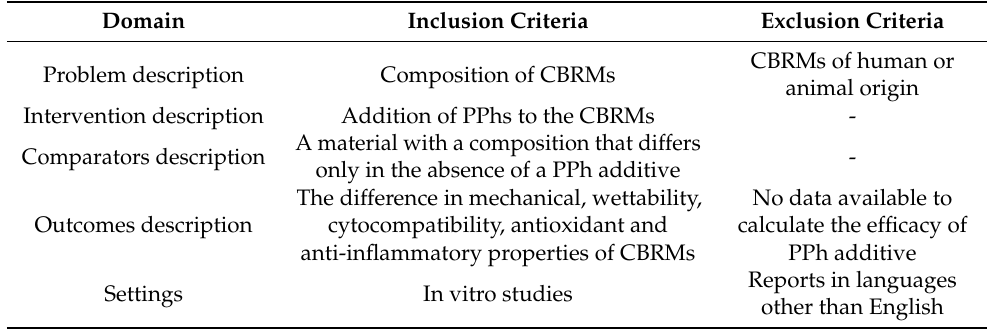
Table 1. Eligibility